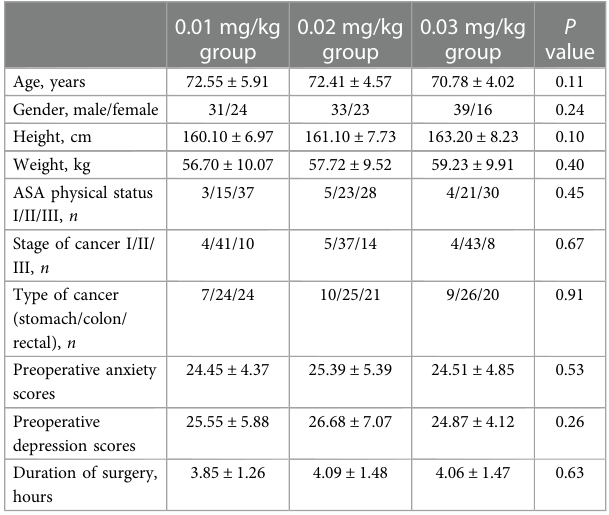
TABLE 1 Demographic and clinical data of the patients.